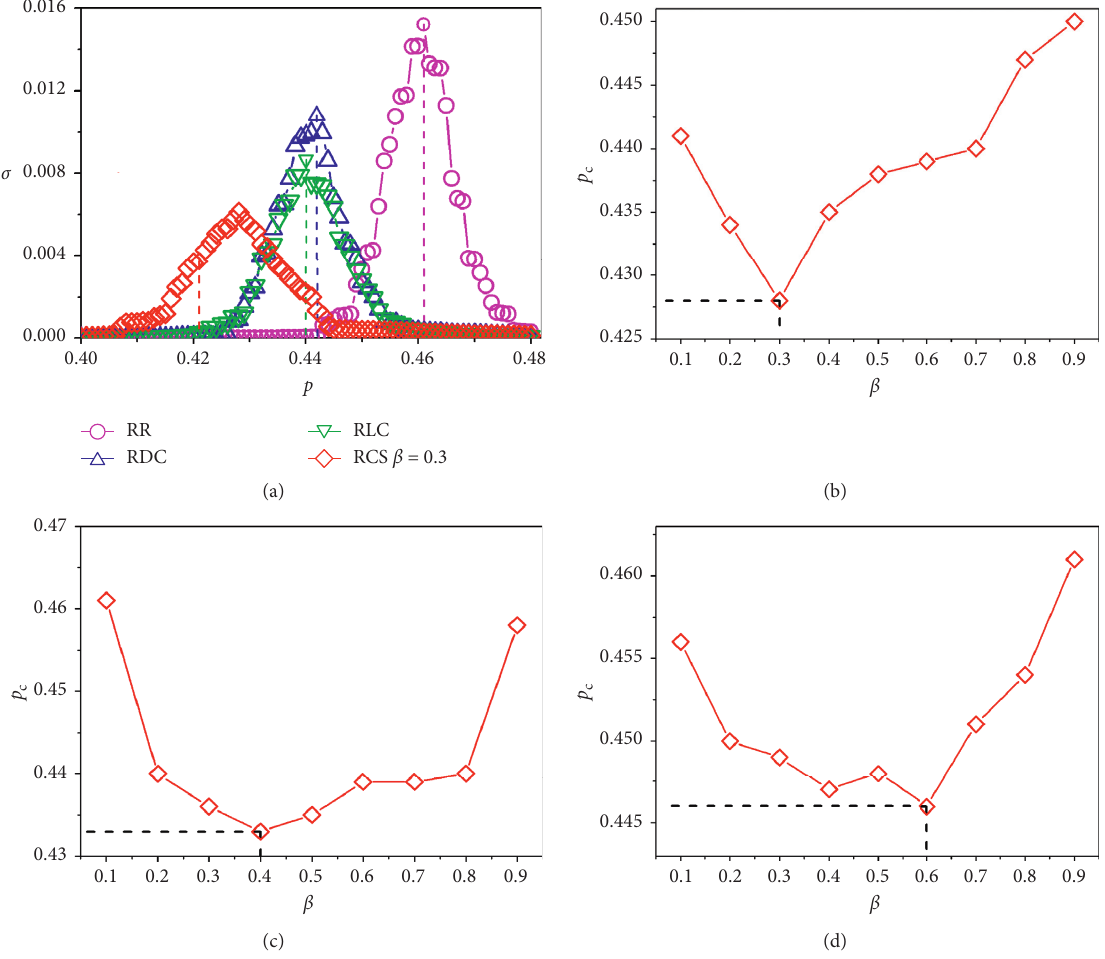
Figure 4: The optimal performance of RCS. (a) The fluctuation of S as a function of the fraction of surviving nodes p for different recovery strategies on the ICNs with ER-ER structures. To identify the critical points p c , we calculate the maximum fluctuation σ of the size of giant component S . For instance, the value of p c of RCS approaches 0.428 as the fluctuation of S at that point reaches the maximum value ( σ � 0.006). (b) The critical point p c of RCS as a function of parameter value β on the ICNs with ER-ER structures. For example, the optimal parameter β o � 0.3 as p c reaches the minimum value. (c) The critical point p c of RCS as a function of β on the ICNs with ER-SF structures. (d) The critical point p c of RCS as a function of β on the ICNs with SF-SF structures.